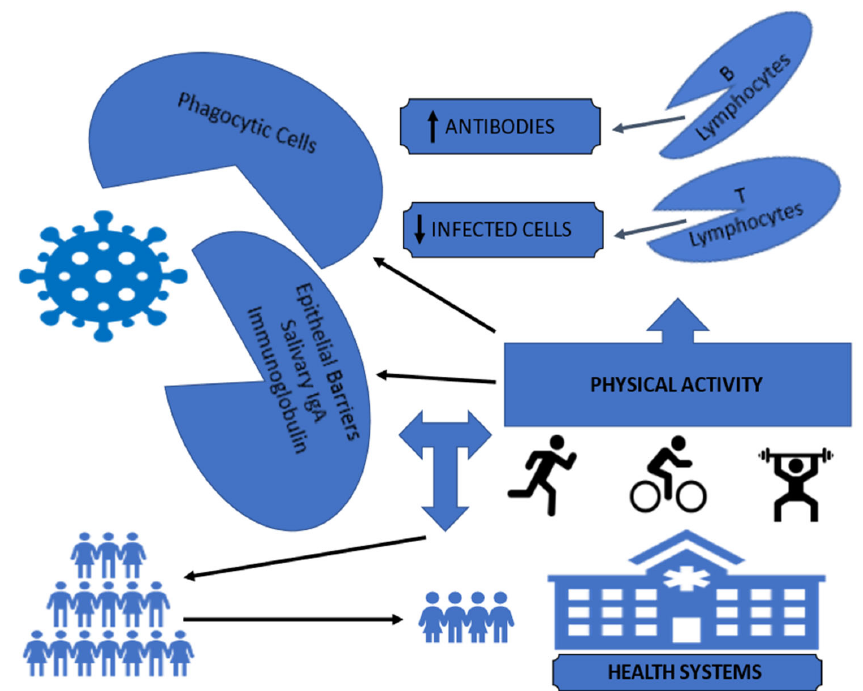
Figure 1. Empowerment the immune system through physical activity with a consequent reduction in the burden on health systems.